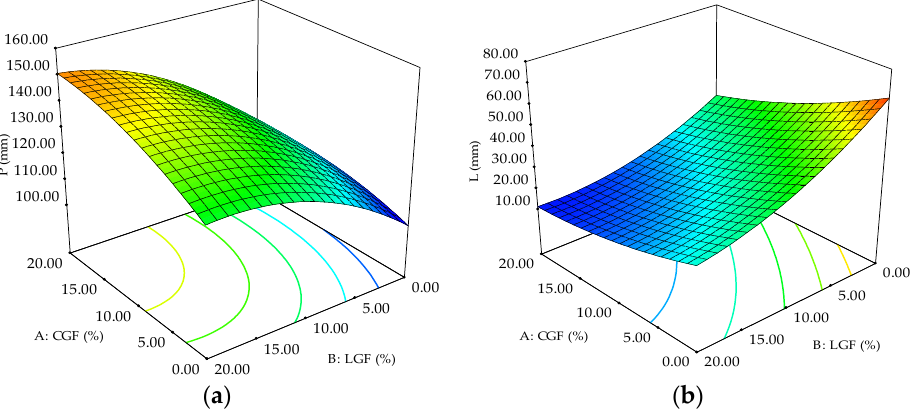
Figure 4. Response surface plot of ( a ) dough elasticity (P) and ( b ) dough extensibility (L) as a function of chickpea germinated flour (CGF) and lupin germinated flour (LGF) addition. Alveograph energy and P/L were also significantly affected ( p < 0.05) by CGF and LGF addition level, while their interaction influenced in a significant manner only P/L (Table 2). Since the models fitted to the data are first-order, the fitted response surfaces are plane. A decreasing trend of alveograph energy was observed as the amount of CGF and LGF raised, while opposite results were obtained for alveograph curve ratio variation (Figure 5).